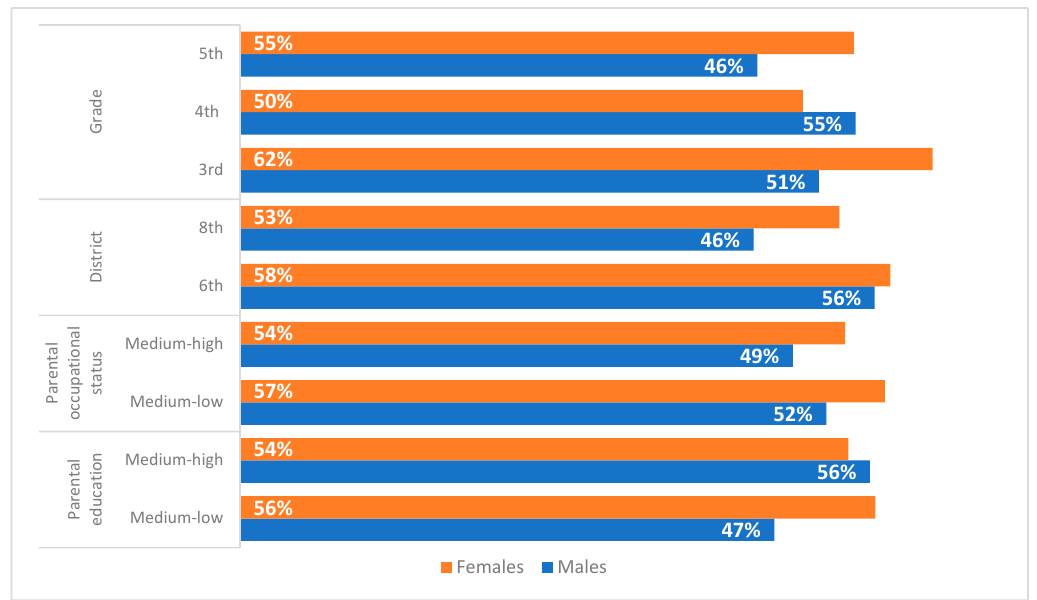
Figure 3. Levels of adherence to male gender roles by sex (% of medium and high levels by school grade, district, parental occupational status and parental level of education).